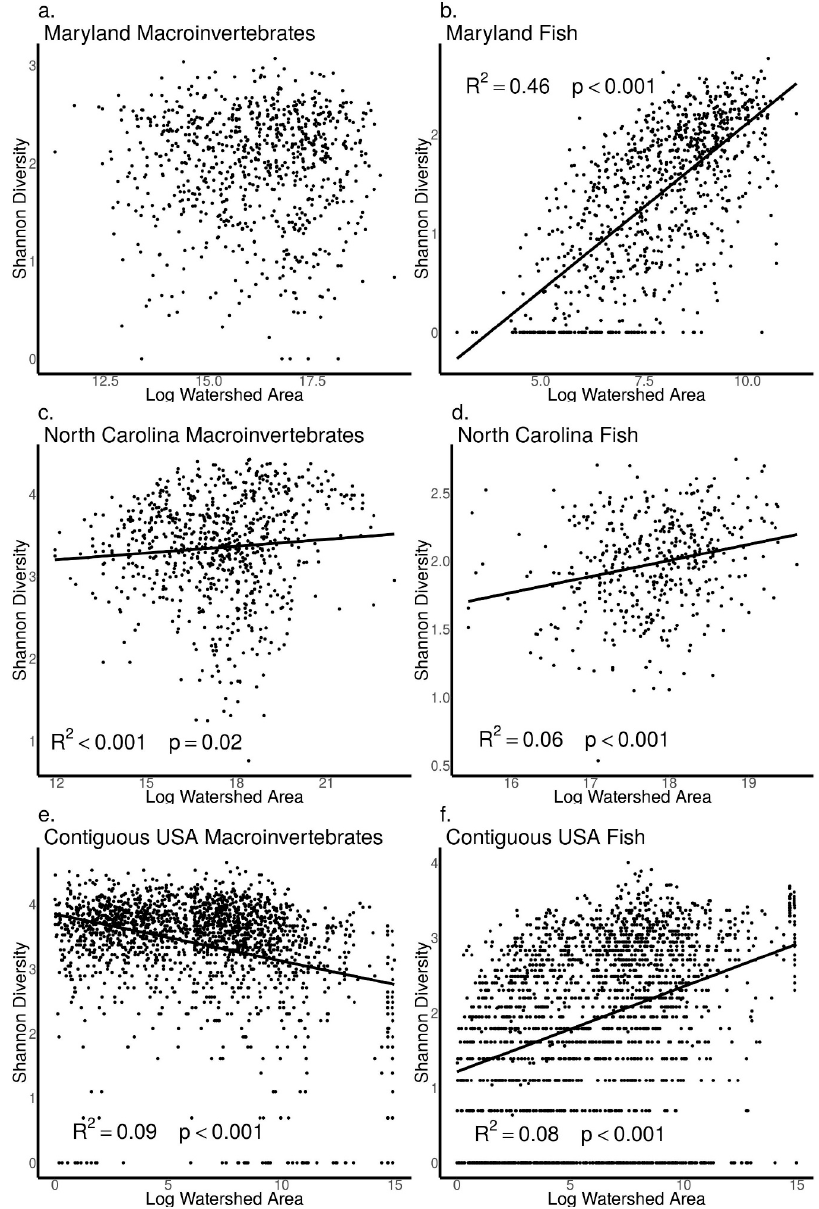
Figure 7. Relationship between Shannon diversity and watershed area (log transformed) for macroinvertebrate ( a , c , e ) and fish ( b , d , f ) communities collected from Maryland (MBSS), North Carolina (NCBMP) and contiguous USA (USEPA). Lines, R 2 and p -values indicate significant positive relationships determined by linear models.